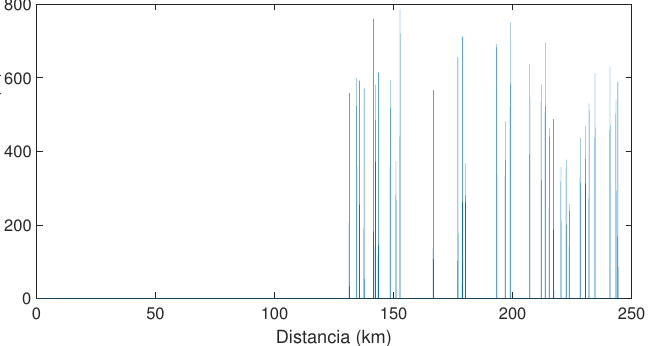
Figure 15. Location of curves and their radii of the route Chiriguaná – Santa Marta . Given the lack of information on speed profiles in the analyzed route, the proposed speed vs. distance profile ( (cid:126) v g vs. (cid:126) D is , g ) assumed that the locomotive moved at the maximum speed allowed by the Colombian rail traffic regulation [36]. This regulation defines a maximum speed of 50 km/h in residential zones and 80 km/h in open zones. Additionally, the speed profile also considered two theoretical stations in two towns (Bosconia and Fundación), where the speed goes down to 0 km/h. Those stations are located at 87 km (Bosconia) and 157 km (Fundación) from the Chiriguaná station. The maximum speed profile ( (cid:126) v max vs. (cid:126) D is ) was also calculated as described in Section 3.4 to determine the speed restrictions. For the train with the S-334 locomotive, (cid:126) v max was greater than the maximum speeds defined by the Colombian regulation at all the points of the track; however, this was not the case for the same train with the S-594-2 locomotive. The (cid:126) v g vs. (cid:126) D is , g and (cid:126) v max vs. (cid:126) D is , g profiles used for this case study are reported in Figures 16 and 17 for the S-334 and S-594-2 locomotives, respectively. It is worth noting that k v = 0.775 is considered to limit the (cid:126) v vs. (cid:126) t for S-334 and S-594-2 locomotives; hence, the speed profile presented in Figure 16 is not affected by (cid:126) v max , while the one presented in Figure 17 is defined by k v · (cid:126) v max for most of the